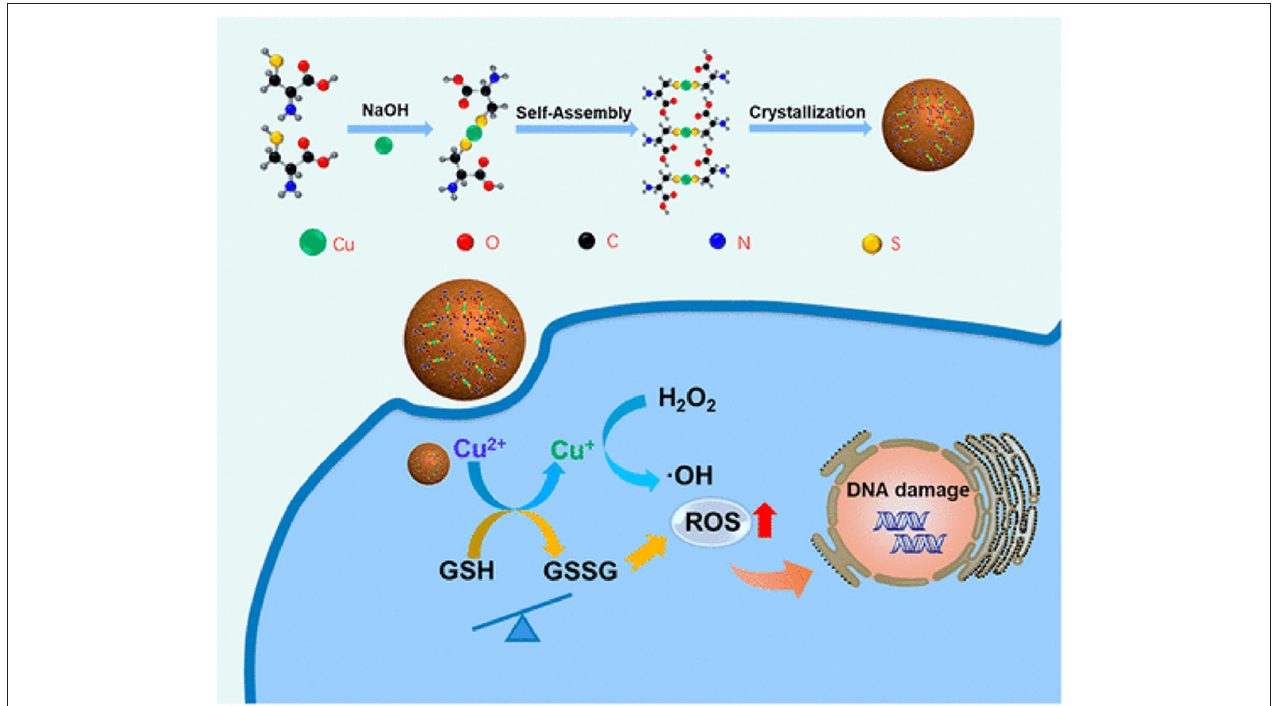
FIGURE 5 | Amino acid-modified copper nanoparticles (CuNPs) induce anticancer effects. CuNPs oxidize glutathione (GSH) to glutathione disulfide (GSSG) and generate Cu + ions, further reacting with endogenous peroxidase to generate hydroxyl radicals to kill cancer cells. Reproduced with permission ( Ma et al., 2018) Copyright © 2019, American Chemical Society